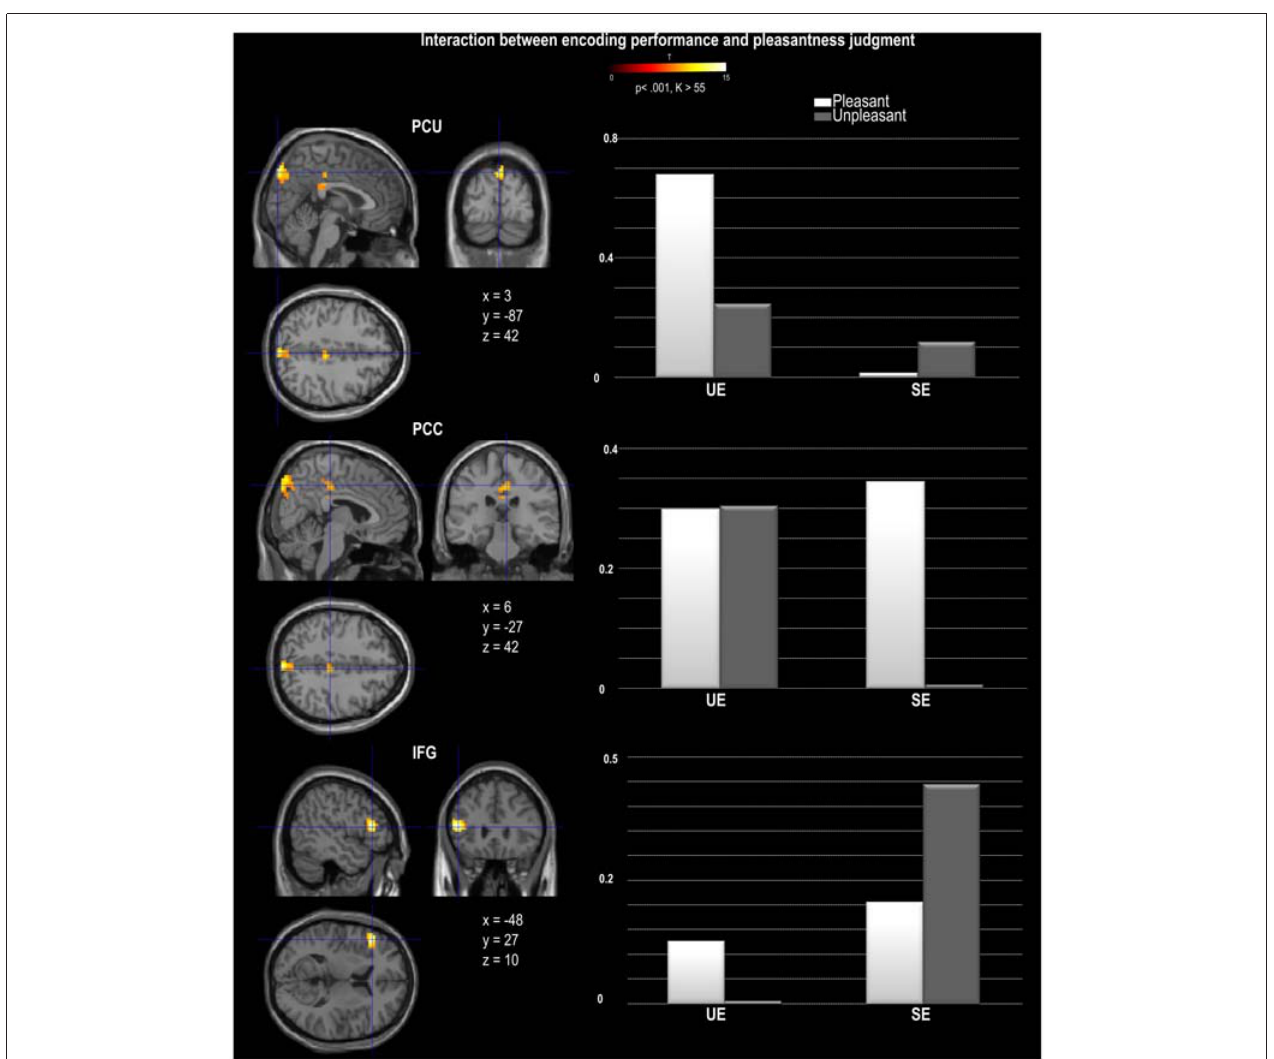
FIGURE 4 | Activation provided by the random effect group analysis on the statistical interaction between pleasantness judgment and encoding performance. The direction of the interaction was represented by the estimates parameters for each experimental condition and each region, PCU, PCC and IFG (inferior frontal gyrus). The activation is projected onto 2D anatomical slices in axial, coronal, and sagittal orientations, MNI coordinates are presented. The color scale indicates the T value of the activation (height threshold T = 3.55, p < 0.001 uncorrected) with a voxel cluster extent estimated with a Monte Carlo simulation ( K = 55). Abbreviations: SE, Successful Encoding; UE, Unsuccessful